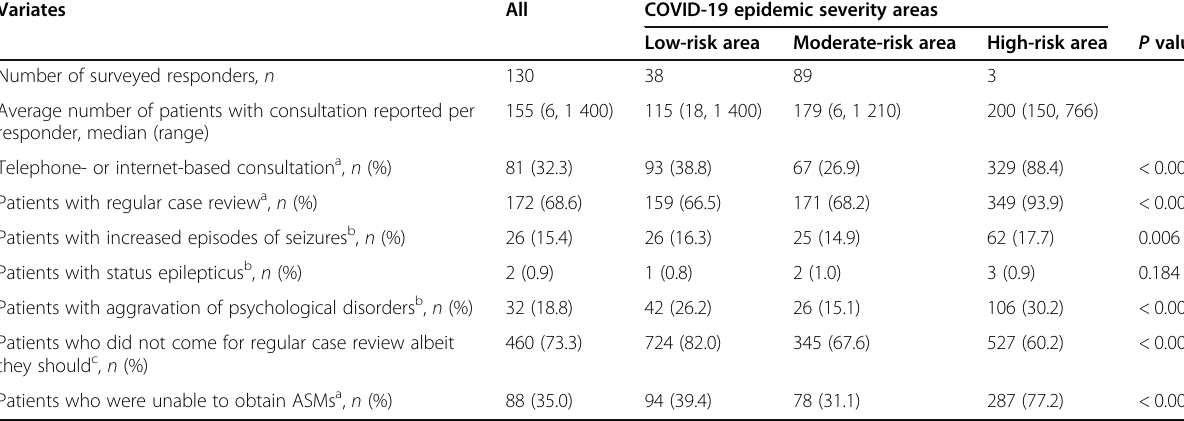
Table 1 Characteristics of people with epilepsy reported by the CAAE board members during the survey Variates